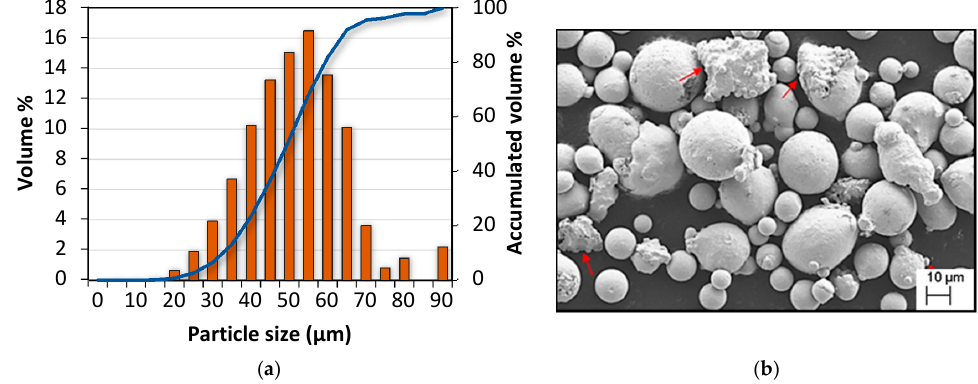
Figure 1. ( a ) Particle size distribution of IN738LC ; ( b ) SEM image of the powder particles showing differences in size and presence of satellites and irregular particles (red arrows).